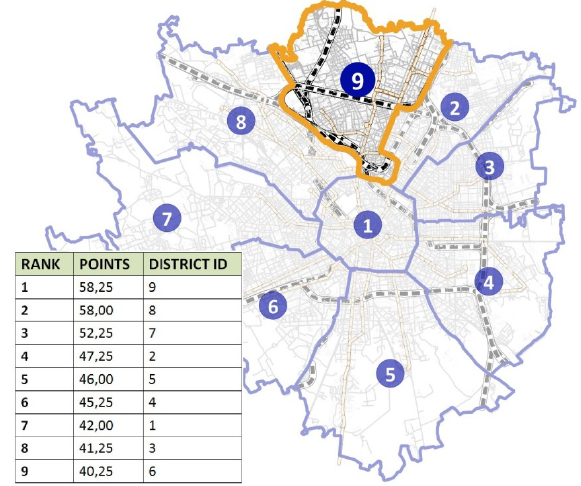
Figure 1: Pilot area selected as urban test site for the Dynamap project and outcomes of the selection